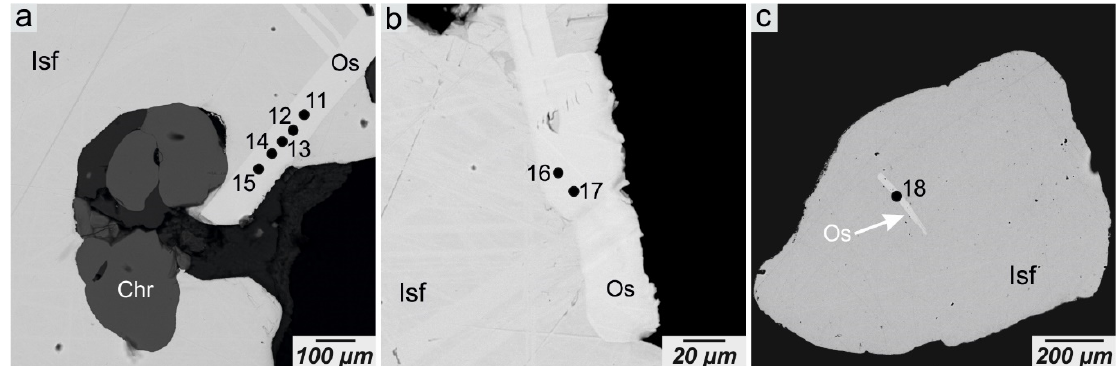
Figure 8. BSE images (SEM) of osmium inclusions in isoferroplatinum from the Travyanistyi proximal placer ( a , b ) and the Glubokinskoe distal placer ( c ). The number of points corresponds to the data in Table 3 (No. 11–18). Isf—isoferroplatinum, Os—osmium, and Chr—chromite. Osmium composition varies considerably (Table 3).